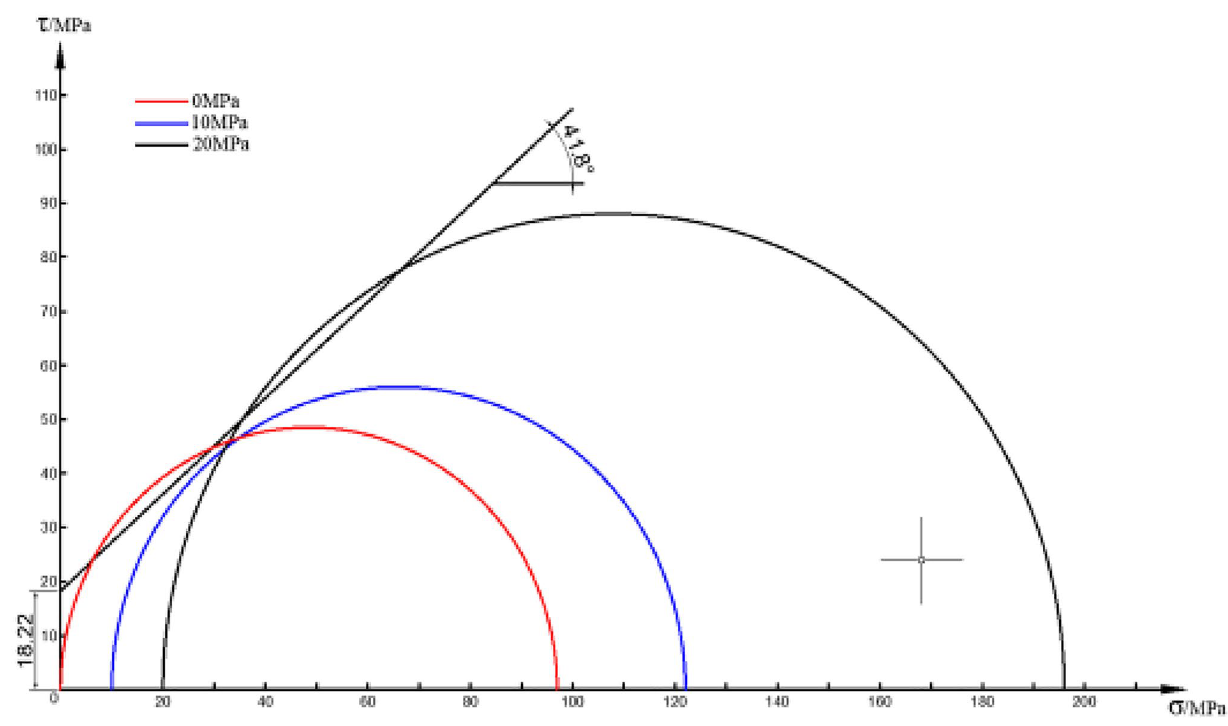
Fig. 5 Moiré circle of shale stress